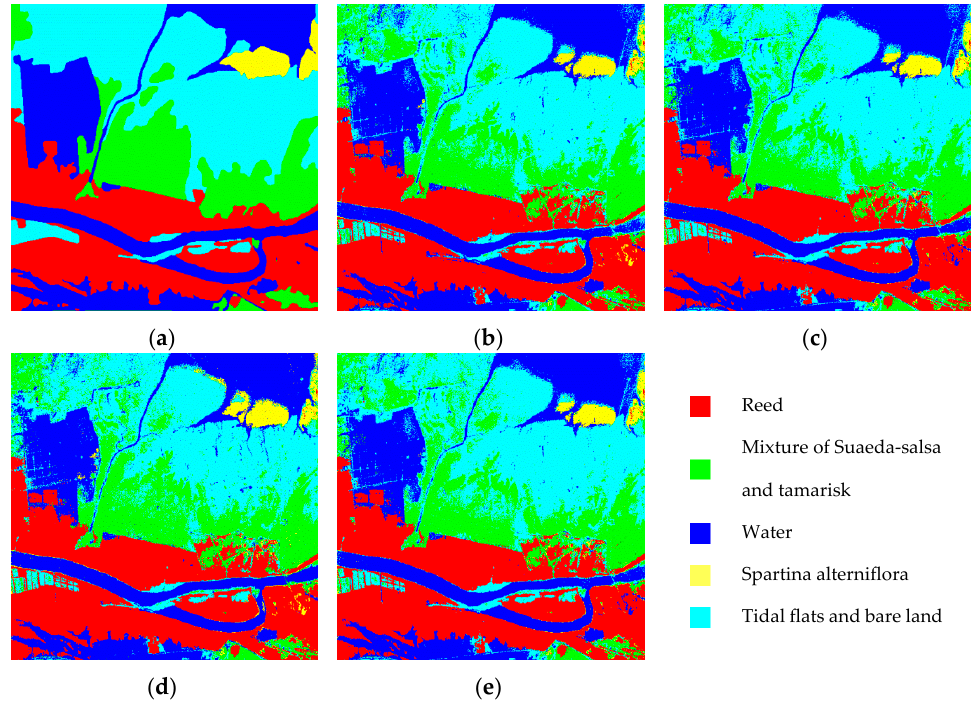
Figure 7. Classification results. ( a ) Ground truth image; ( b ) CNN with an accuracy of 83.34%; ( c ) F–R CNN with an accuracy of 82.89%. The training samples of ( b ) and ( c ) are the original training samples (6090 samples), and the batch training size is two samples. ( d ) CNN model with an accuracy of 84.02%; ( e ) F–R CNN model with an accuracy of 84.93%. The training samples of ( d ) and ( e ) are the expanded training samples (20 × 6090 samples), and the batch training size is 10